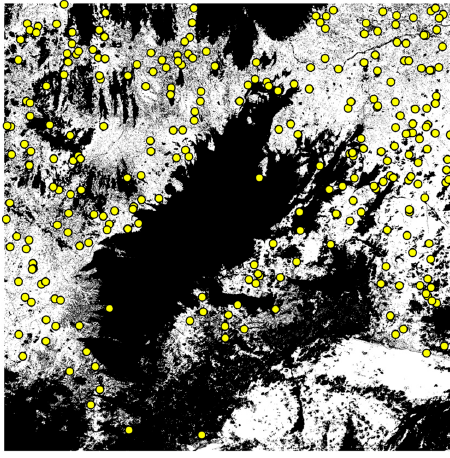
Figure 3. Mask image used to exclude cloudy pixels (black) from the analysis. Check points used for spectral assessment are in yellow. Image extent correspond to a whole S2 tile (Orbit:65, Tile: T32TMQ). Mapping of not-cloudy pixels was achieved by thresholding the above mentioned band 10 and QA layers. Threshold values were defined by photointerpretation and the following values used, equal for all of the images. For S2 images, a unique threshold for the available images was determined by photo interpretation of clouds on screen using band 10 (cirrus). This spectral band corresponds to